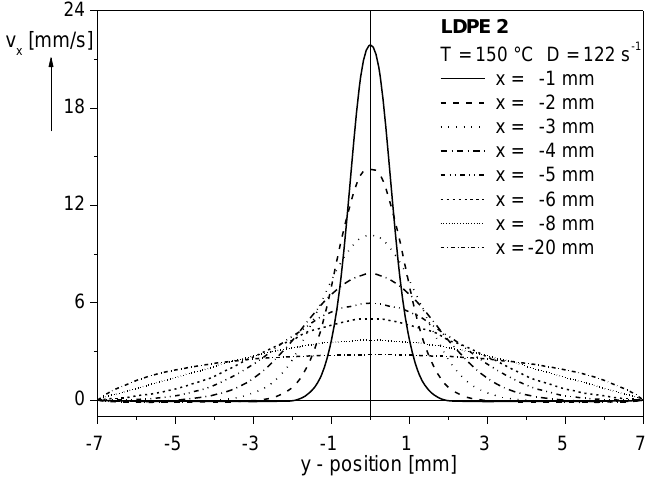
Figure 9. Velocity components 𝑣 𝑥 (𝑦) in the quadratic reservoir of a slit capillary with the height 1 mm at different positions 𝑥 from the entrance plane for an LDPE at 150 °C and an apparent shear rate of 𝐷 = 122 s −1 . The measurements were carried out by laser-Doppler velocimetry (LDV) [21].